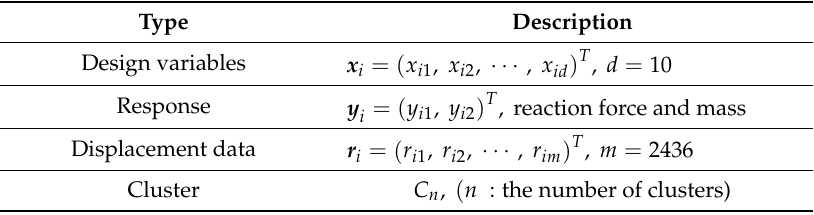
Figure 2. Optimization technique. ( a ) Proposed optimization technique; ( b ) traditional optimization technique. RSM—response surface model. Table 3. Data structure for optimization.